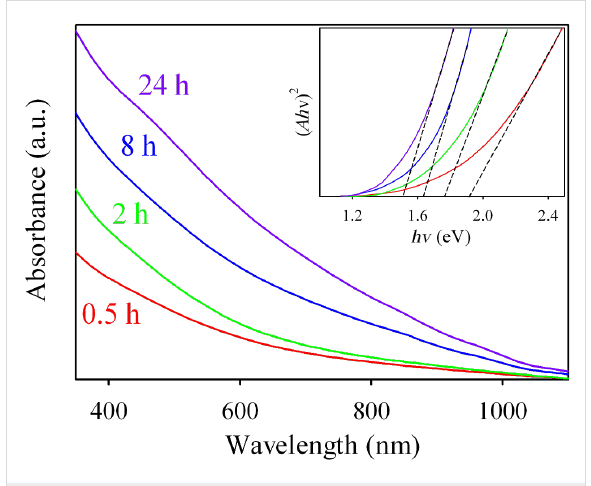
Figure 9: UV–visible absorption spectra of the CZTS nanocrystals synthesized at different reaction duration and the inset image shows the ( Ah ν ) 2 vs h ν plots with corresponding fitting of the